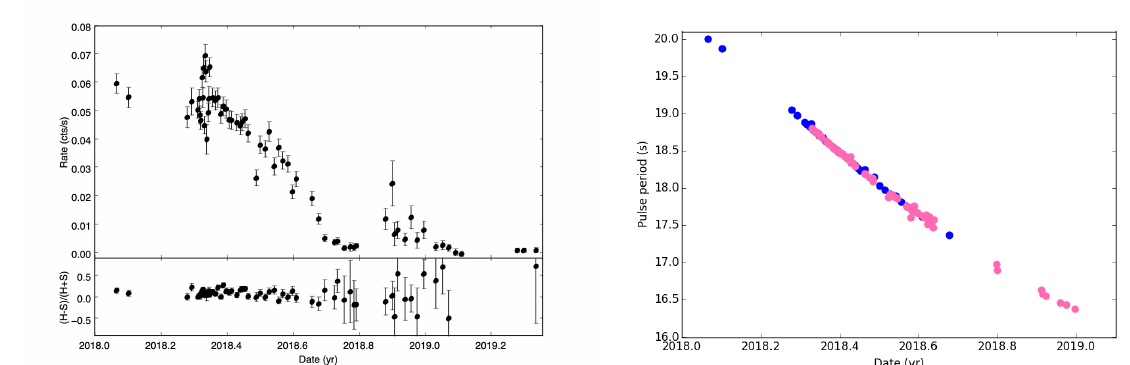
Figure 7. Left : Swift /XRT long term light curve from 2018 January to 2019 May. The corresponding hardness ratios ( S : 0.2–1.5keV, H : 1.5–10keV) are shown in the bottom panel. Right : Evolution of the pulse period from NICER (pink) and Swift (blue) data covering the period from January 2018 to January 2019, when pulsations could be